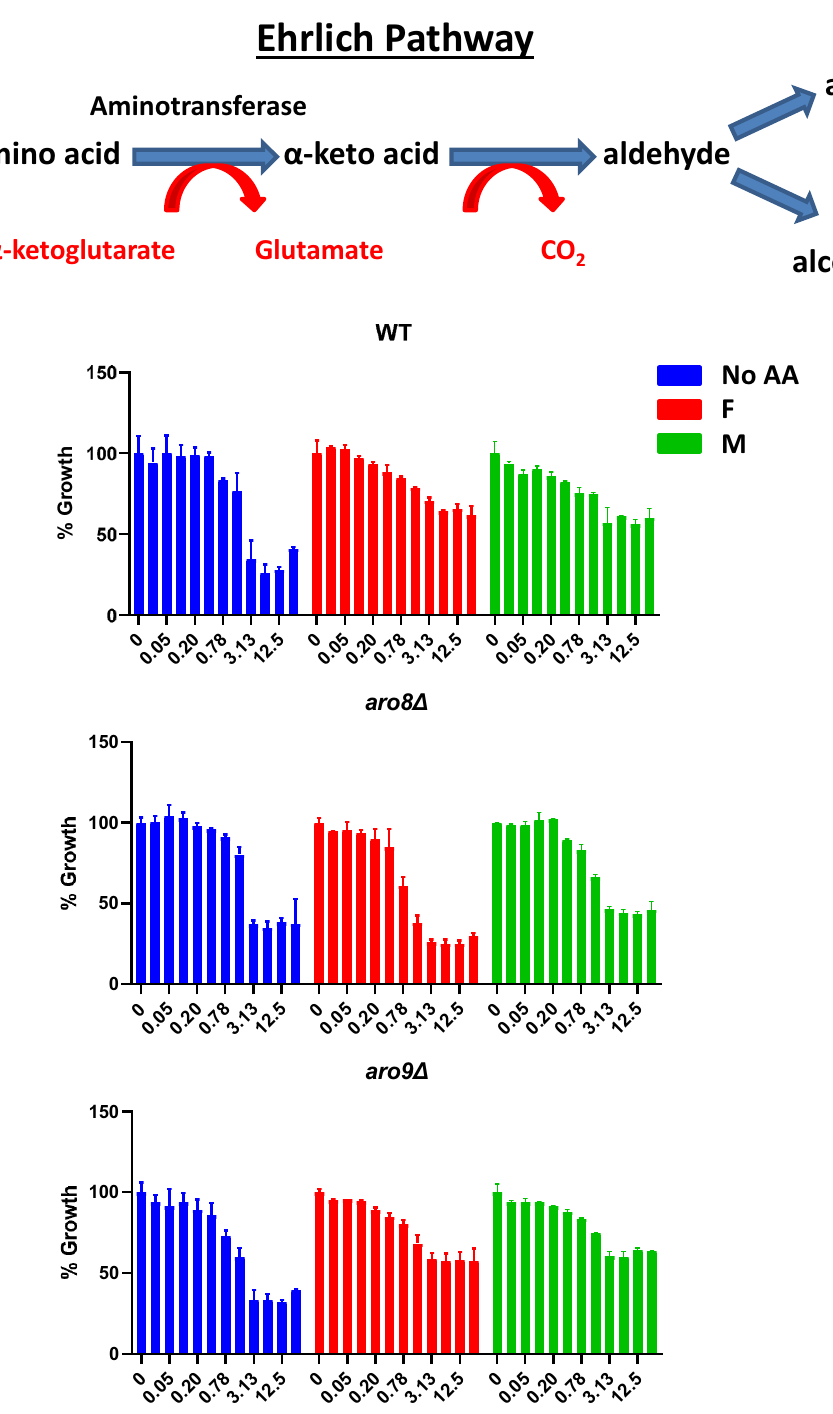
Figure 7. Catabolism of phenylalanine via the Ehrlich pathway is required for suppression of DEP-toxicity. ( A ) Catabolism of an α-amino acid via the Ehrlich pathway. ( B ) Wild type, aro8Δ and aro9Δ cells (Σ1278b background) growing in minimal urea medium in the absence (No AA) and presence of 5 mM phenylalanine (F)/methionine (M) were exposed to two-fold serial dilutions of DEP (maximum concentration at 25 mM). Normalized growth of various cultures is depicted as mean ± SD ( N =